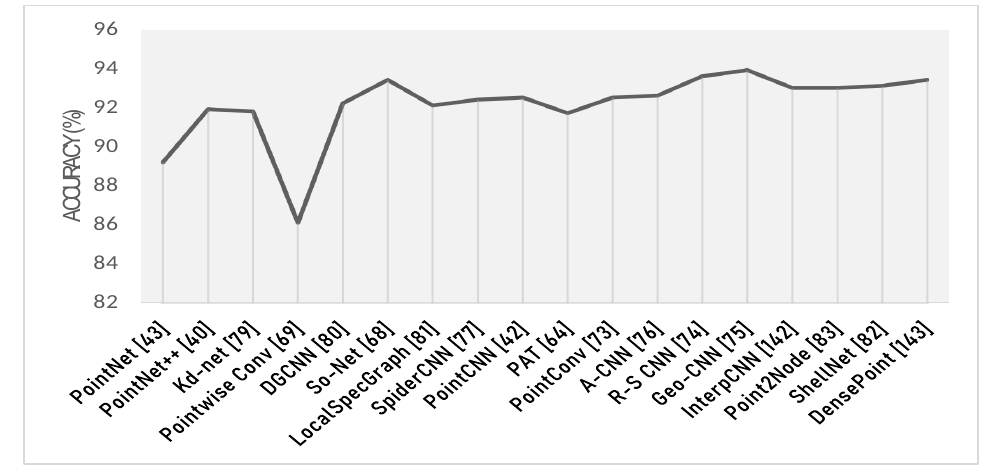
Figure 10. Timeline of the classification accuracy of ModelNet40.